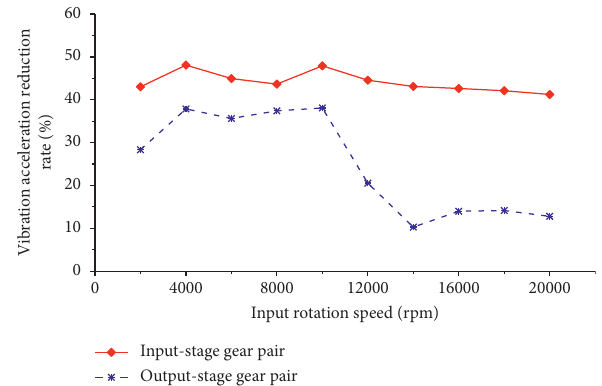
Figure 31: Vibration reduction effect of the system with the modification of output-stage